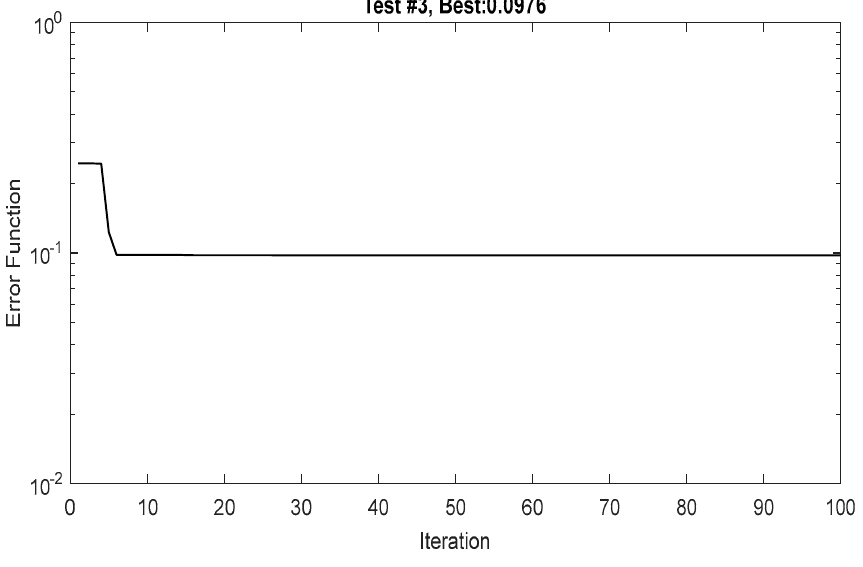
Table 3. Best values of error function at each